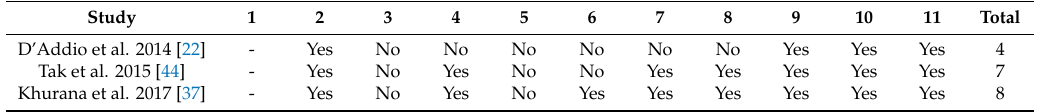
Table 3. PEDro scores obtained by the di ff erent studies included in the systematic review.